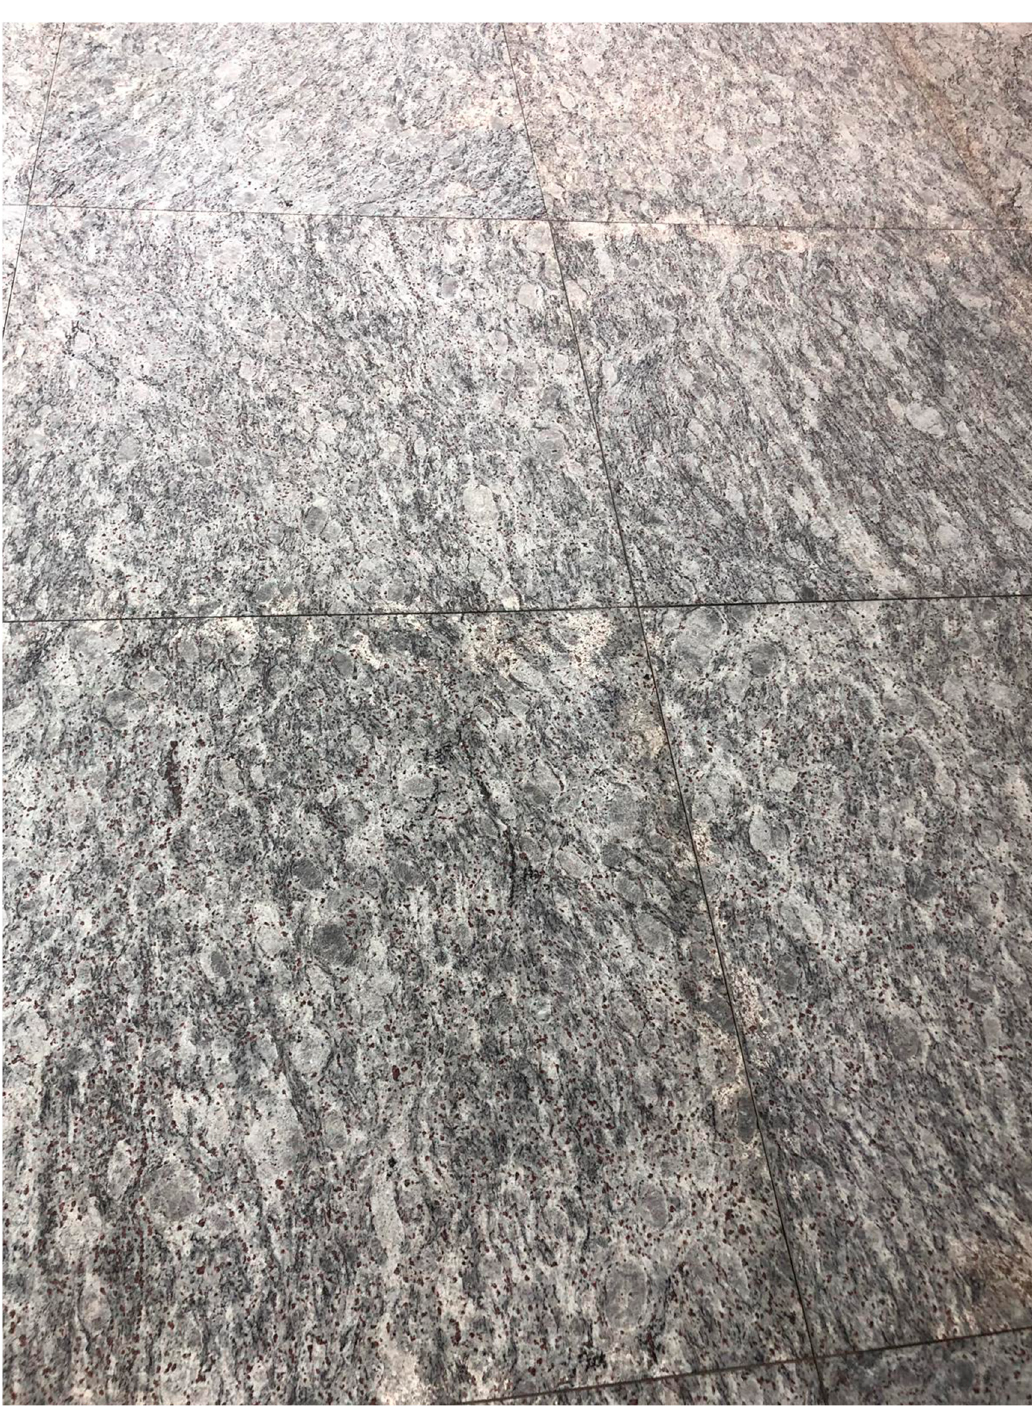
Figure 2. Original zoomed out image of a floor tile that captures one such “hallucination” and features a monochrome image resembling the perceived pathological entity featured in figure 1.